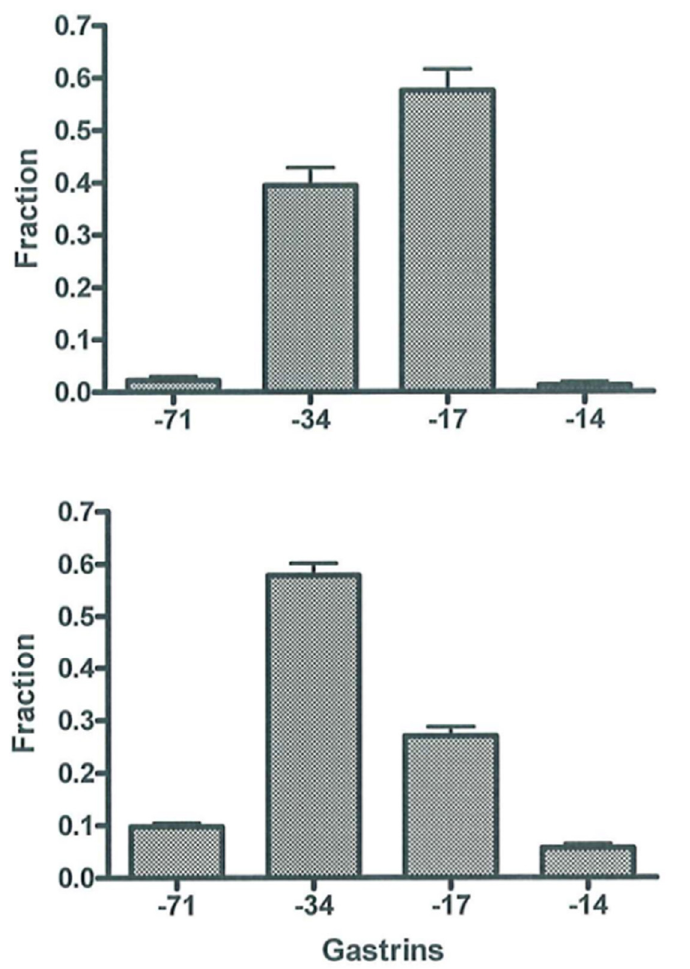
Figure 4. Molecular forms of gastrin ( − 71, − 34, − 17 and − 14) in normogastrinemic serum or plasma (upper panel) and in hypergastrinemic plasma (lower panel). Data from [38] with permission. Table 2. Plasma concentrations of amidated gastrins versus gastrin-17 in consecutive gastrinoma patients.